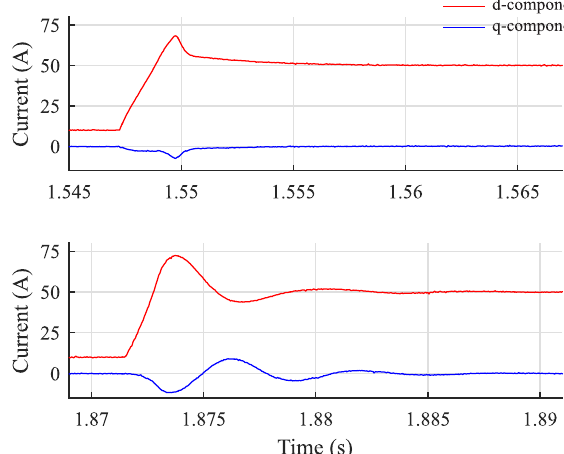
Figure 10. Step response of currents in dq-domain with well-designed ( upper ) and poorly designed ( lower ) current